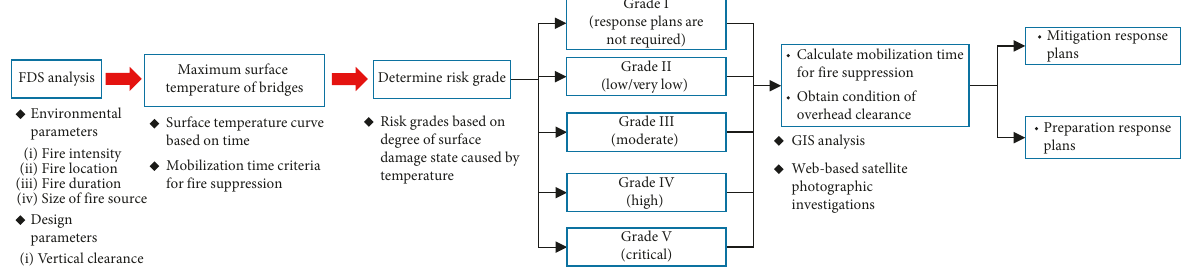
Figure 3: Risk grade process and response plans.